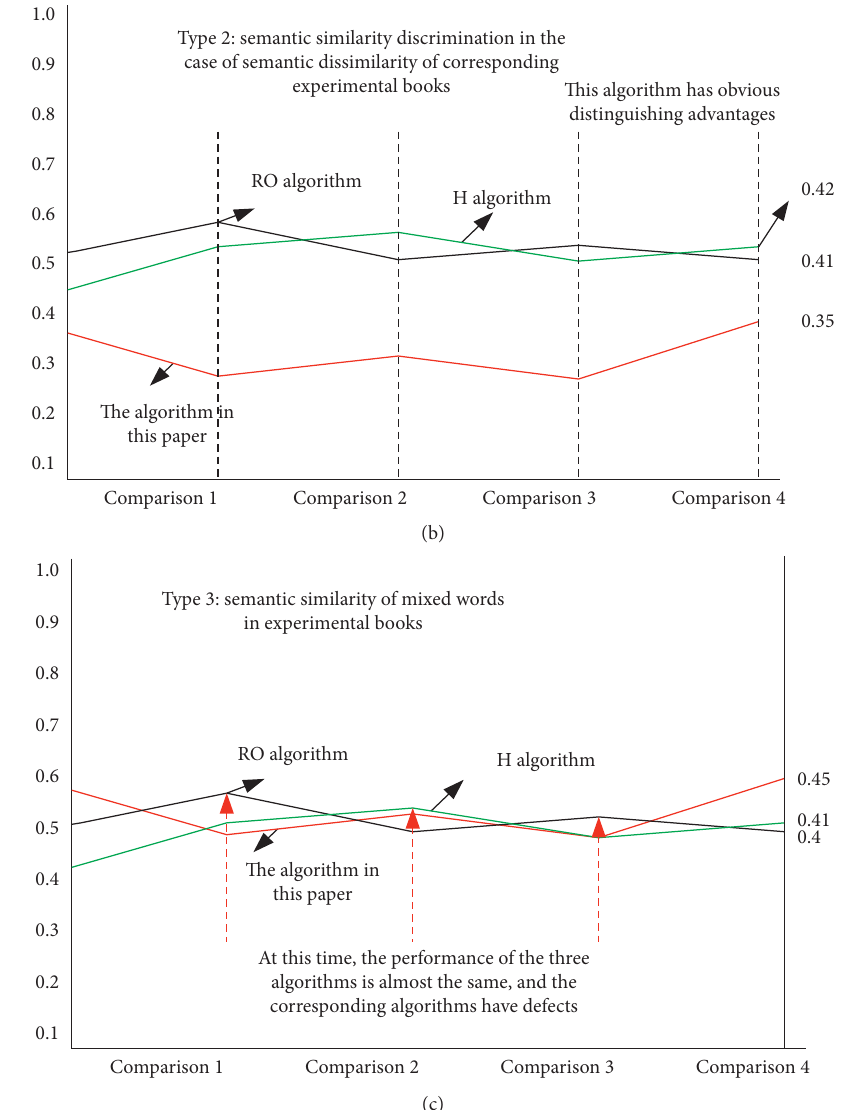
Figure 7: Text information similarity curve of special data resource description framework type: (a) type I; (b) type II; (c) type